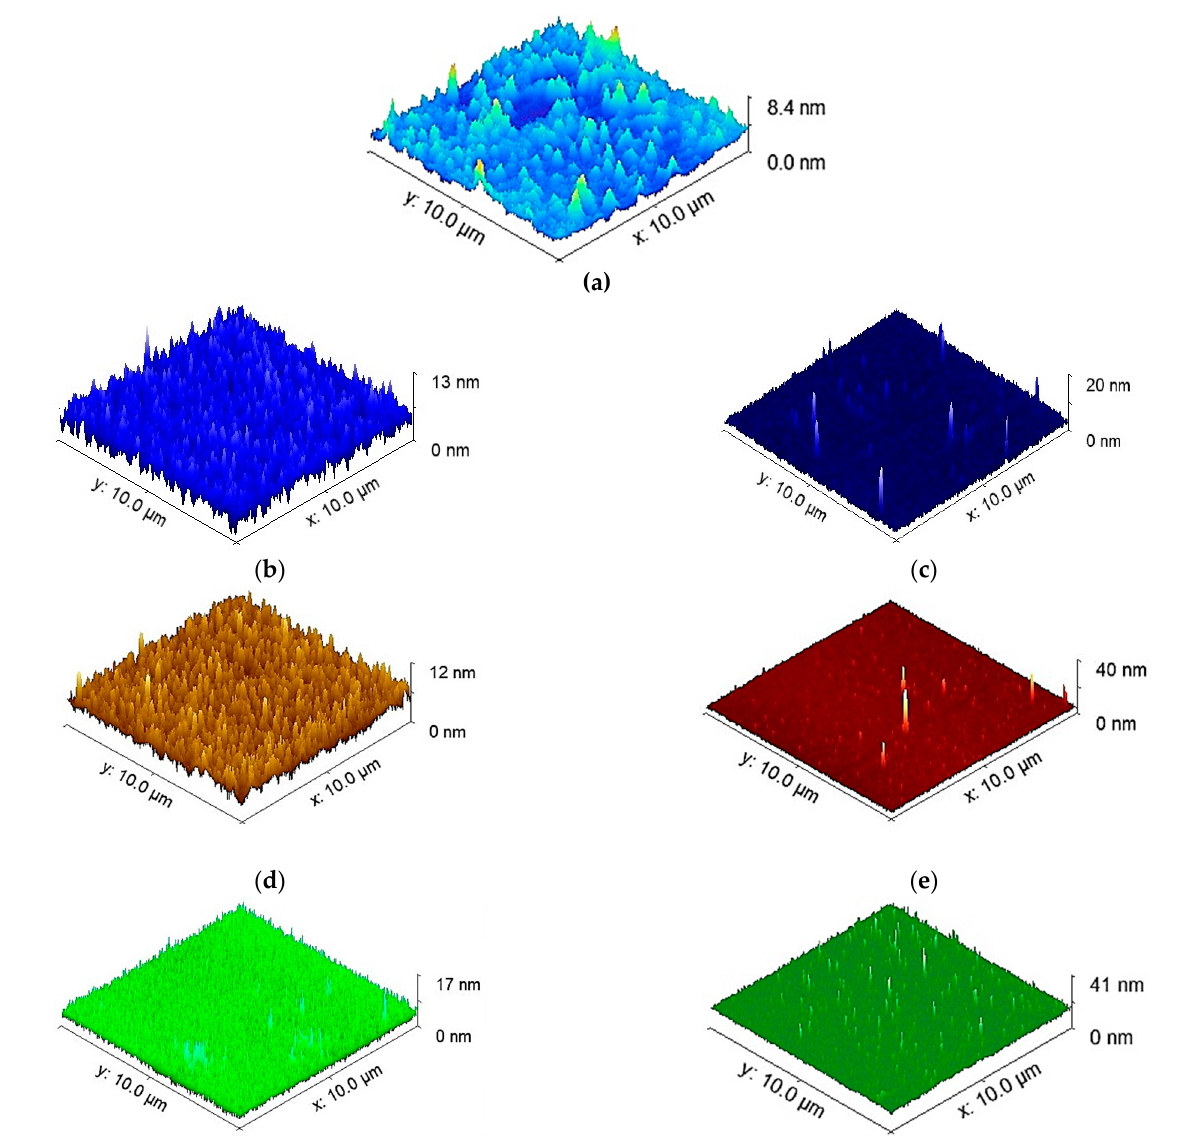
Figure 5. Three-dimensional topographies of the uncoated surface ( a ), silver surface ( b , c ), gold surface ( d , e ), and Ag–Au compound surface ( f , g ). ( a ) uncoated silicon substrate. ( b ) Silver coating with a thickness of 120 nm. ( c ) Silver coating with a thickness of 500 nm. ( d ) Gold coating with a thickness of 120 nm. ( e ) Gold coating with a thickness of 500 nm. ( f ) Com- pound coating with a thickness of 120 nm. ( g ) Compound coating with a thickness of 500 nm. Table 2. Surface parameters of silver and gold single layers and Ag–Au compound layers.